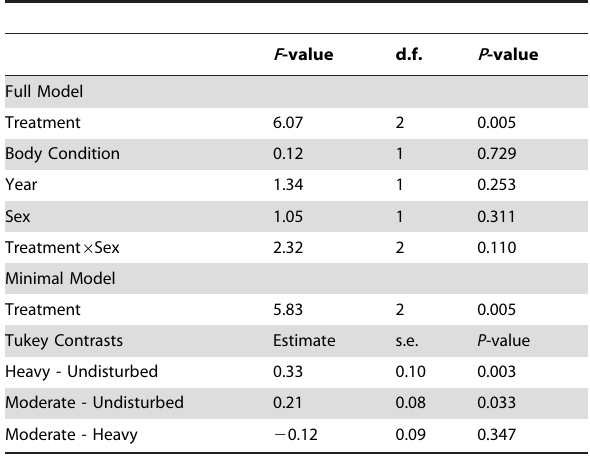
Table 3. Results of a linear mixed model for nestling baseline corticosterone.